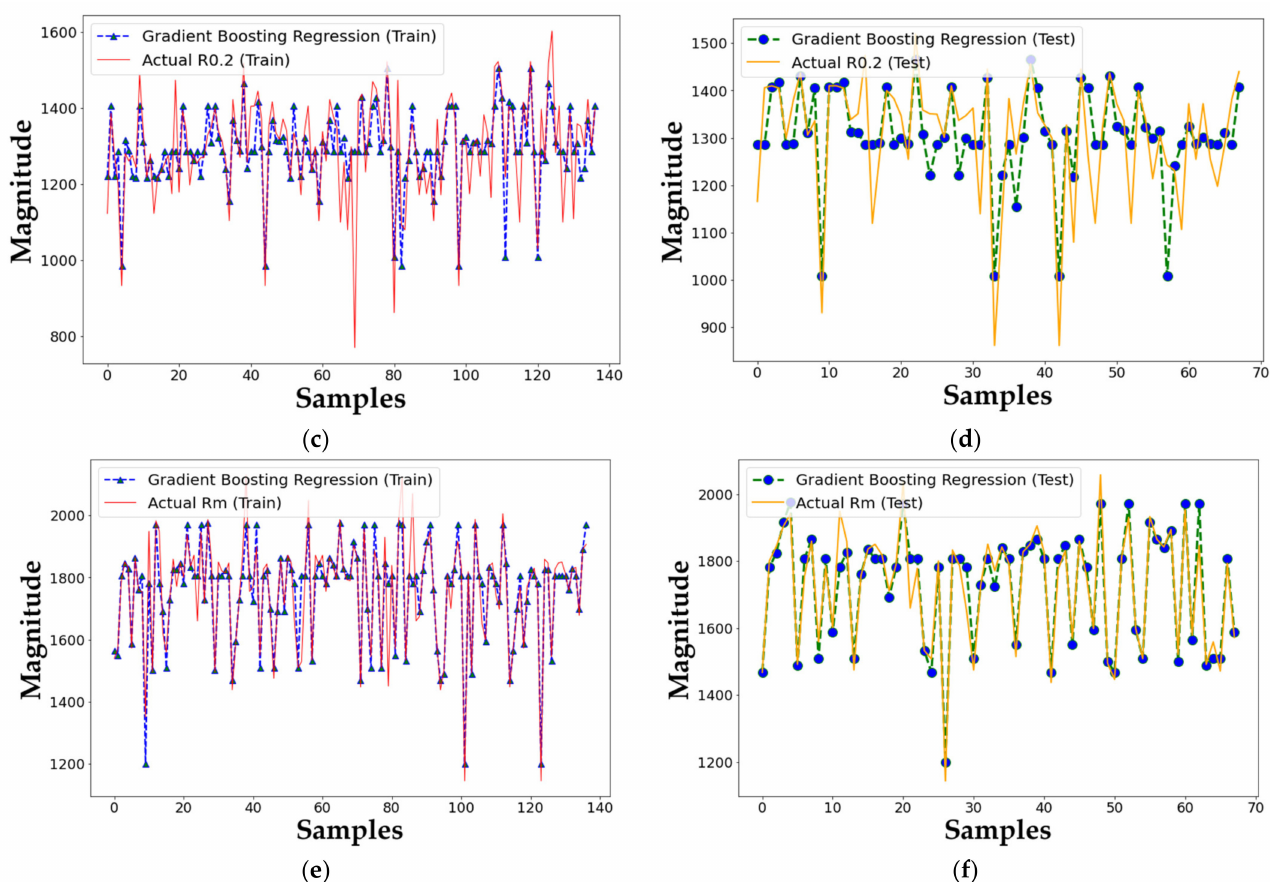
Figure 12. Validation of the Gradient Boosting Regression Algorithm in modelling the digital twins of the alloy based on HV10 ( a , b ); R0.2 ( c , d ); Rm ( e , f ) in the presence of all inputs including heating, QT, PT, and Pt; ( a , c , e ): Train and ( b , d , f ): Test.